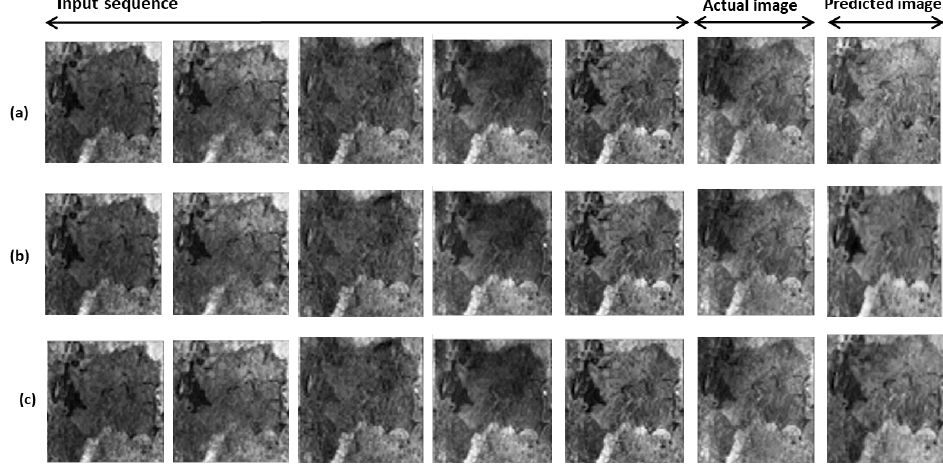
Figure 10. Prediction results obtained for WRT with: ( a ) CNN-LSTM model; ( b ) ConvLSTM model; ( c ) Stack-LSTM model. timestep =